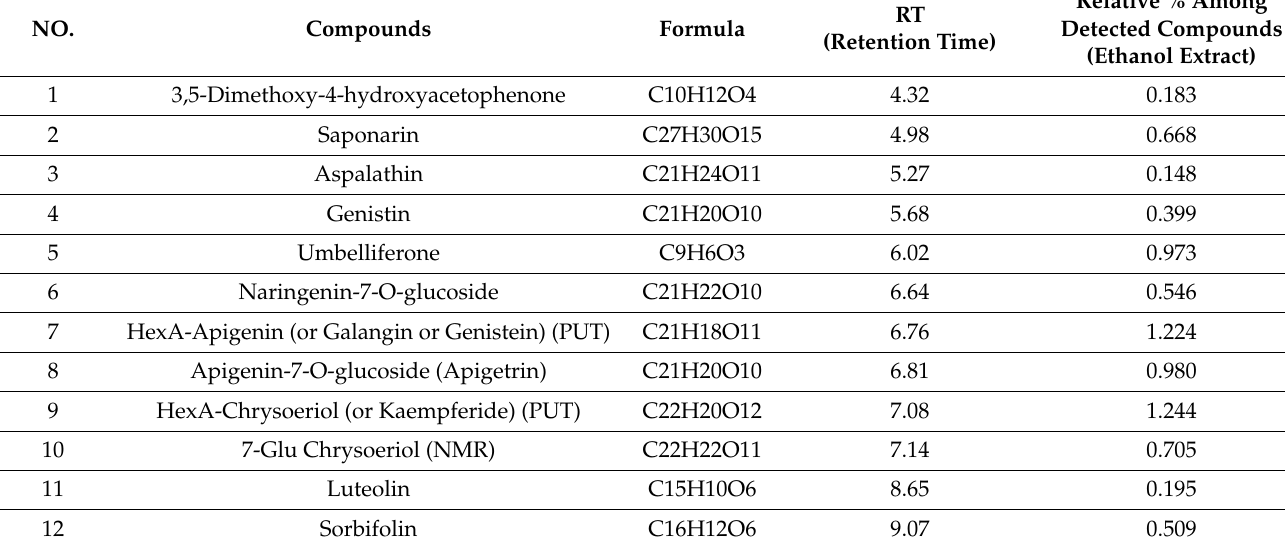
Table 1. LC-MS analysis of X. spinosum ethanol